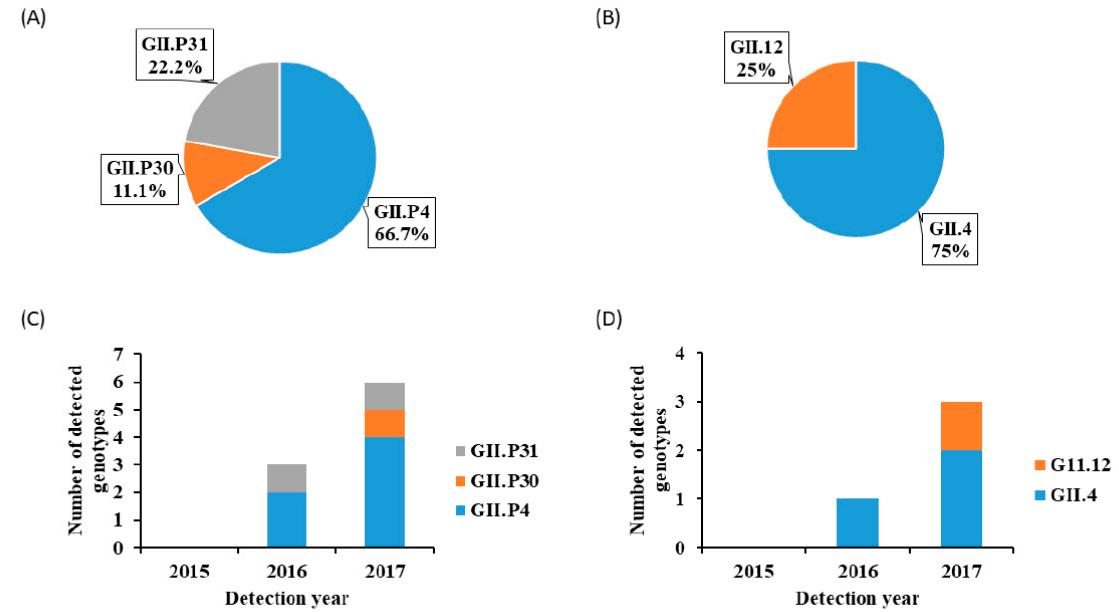
Figure 2. NoV distribution in children with acute gastroenteritis in Ogun State, Nigeria, from February 2015 to April 2017. ( A ) RdRp genotypes, ( B ) VP1 genotypes, ( C ) RdRp genotypes by year, and ( D ) VP1 genotypes by year.